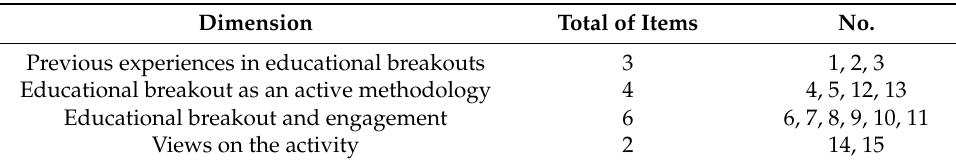
Table 3. Items of the post questionnaire. Dimension Total of Items No. Previous experiences in educational breakouts 3 1, 2, 3 Educational breakout as an active methodology 4 4, 5, 12, 13 Educational breakout and engagement 6 6, 7, 8, 9, 10, 11 Views on the activity 2 14,